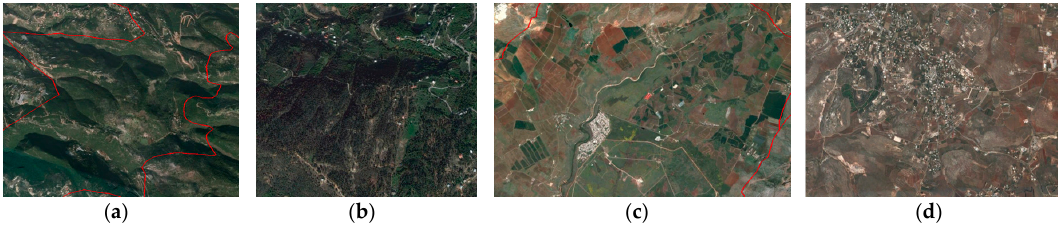
Figure 6. Naturalness rank per each of the LDUs: ( a ) Mostly Natural, ( b ) Even Mix, ( c ) Mostly Cultivated and ( d ) Semi-Natural.